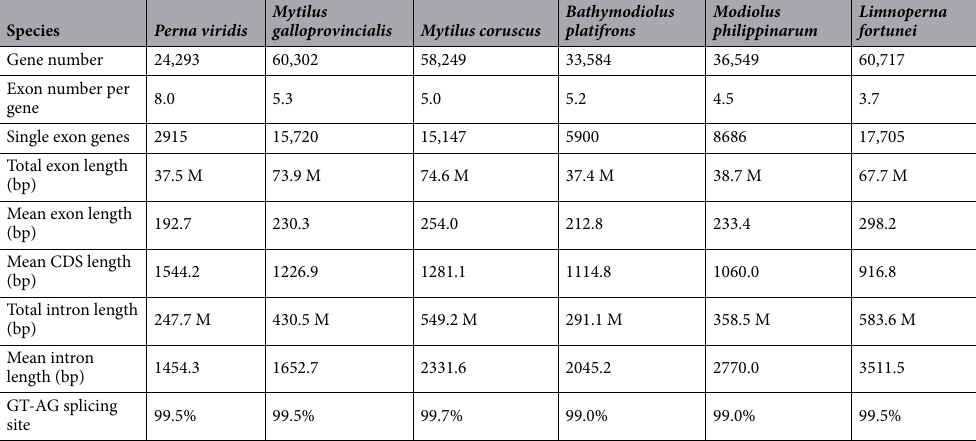
Mytilus galloprovincialis (%) Mytilus coruscus (%)